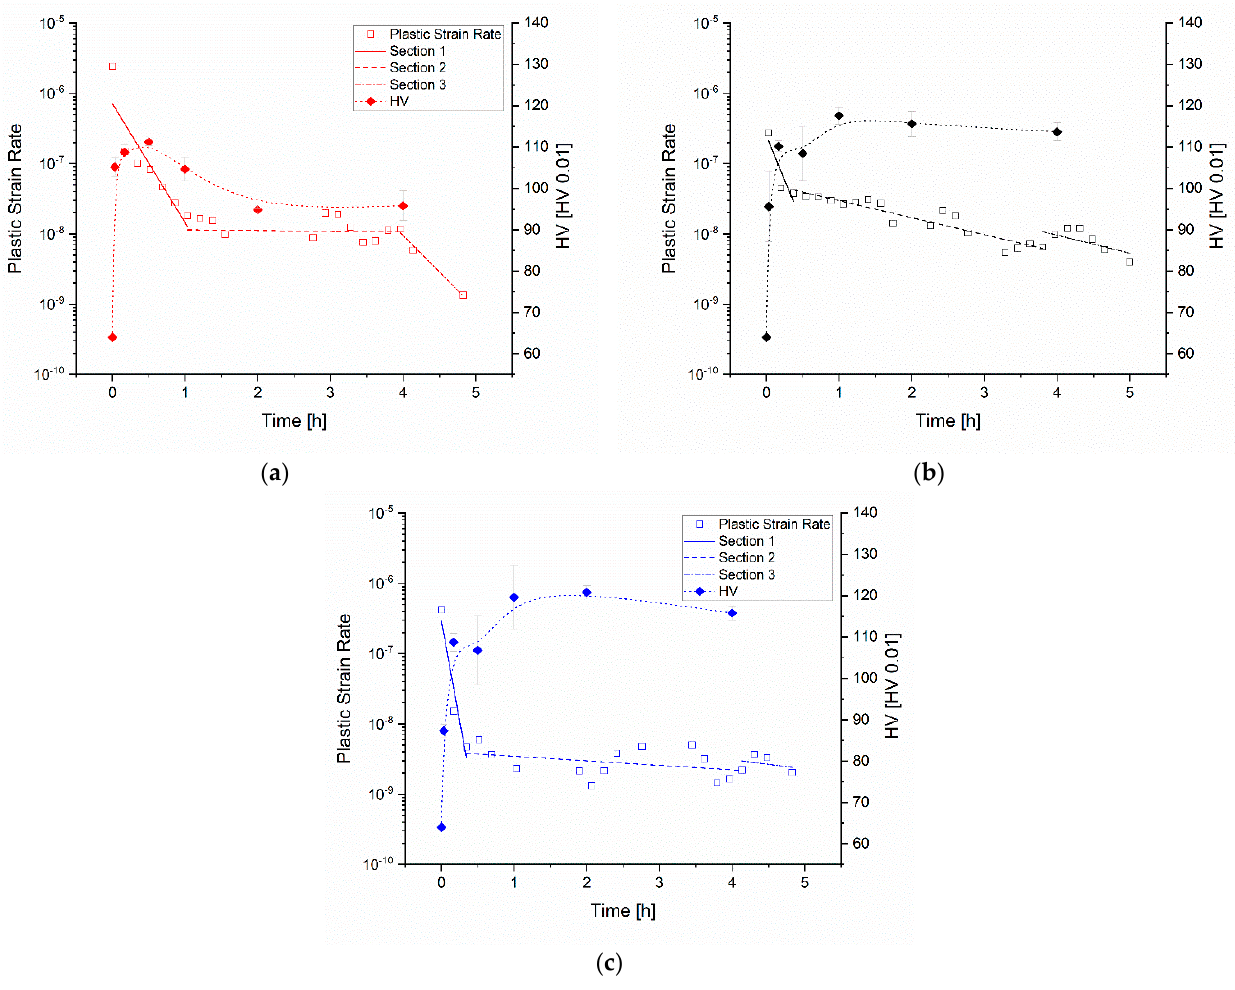
Figure 15. Definition of the 3 different sections of the PSR and comparison with hardness evolution curves, shown as an example on tests in SHT condition and tested at: ( a ) 230 °C; ( b ) 200 °C; ( c ) 180 °C.